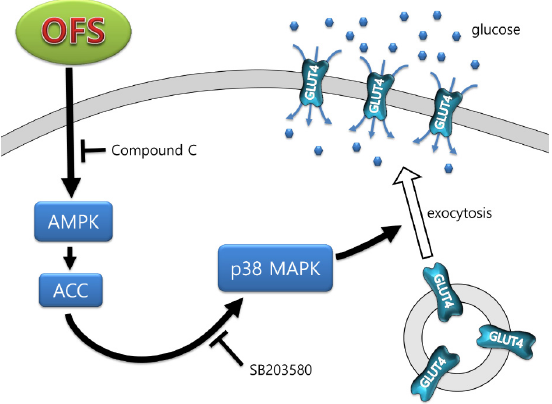
Figure 7. Schematic summary of the possible molecular mechanism by which OFS regulates glucose uptake in muscle cell.